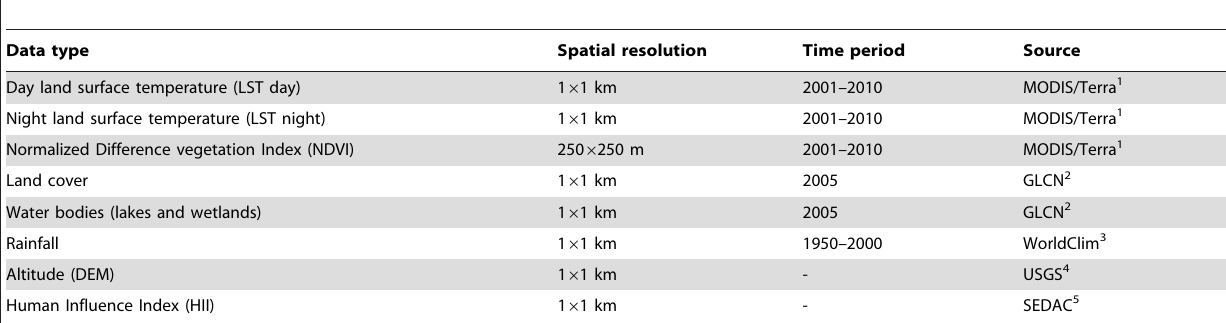
Table 1. Properties and sources of the remotely sensed and other environmental predictors used to model LF prevalence in